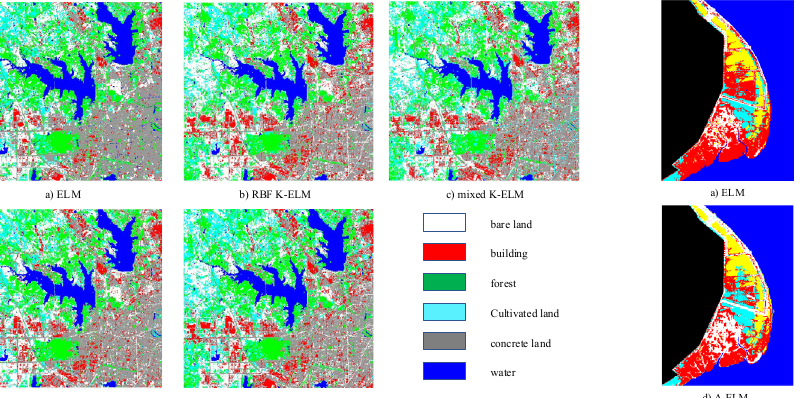
Figure 7 . Classification result of Chongming Dongtan dataset.